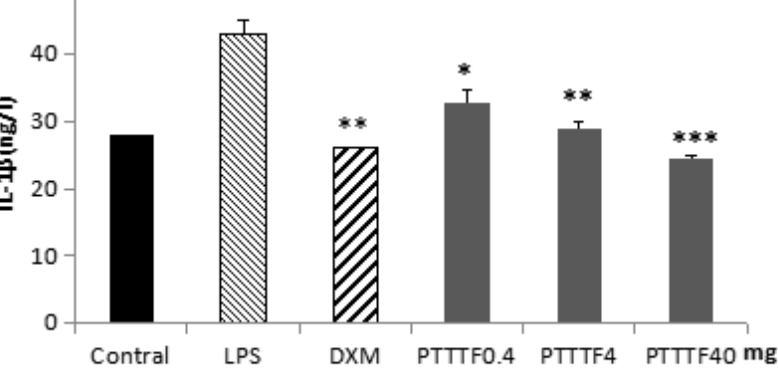
Figure 2: Effect of PTTTF on the content of IL-1β in LPS-induced RAW 264.7 cells ( n =3). *: P < 0.05, **: P < 0.01, ***: P < 0.001, compared with LPS group.